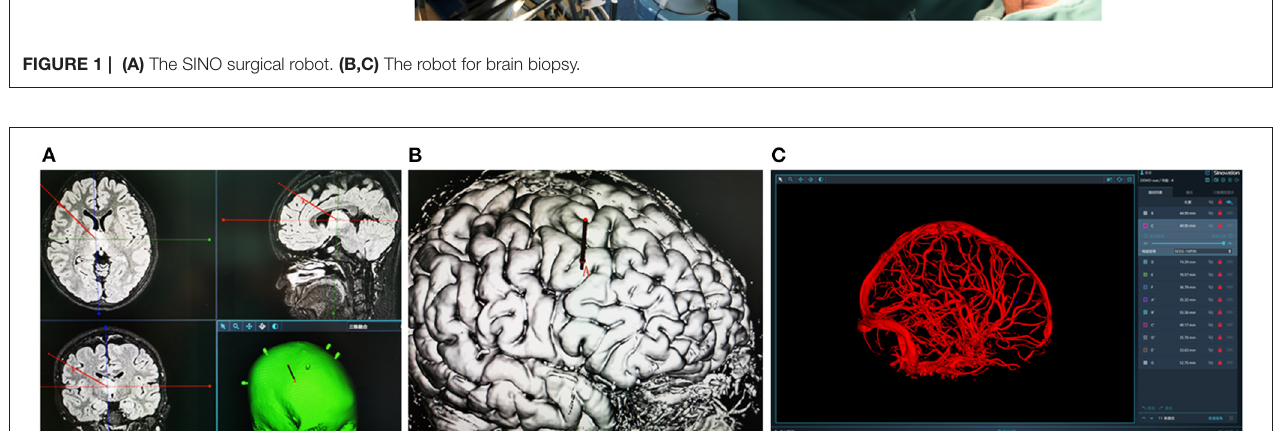
FIGURE 2 | (A,B) Design the stereotactic trajectory on the Sinoplan software. (C) Three-dimensional (3D) visualization technology of craniocerebral vascular.